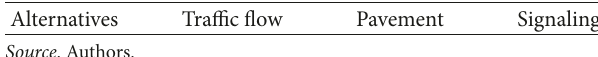
Table 3: Alternatives comparative (operating costs).